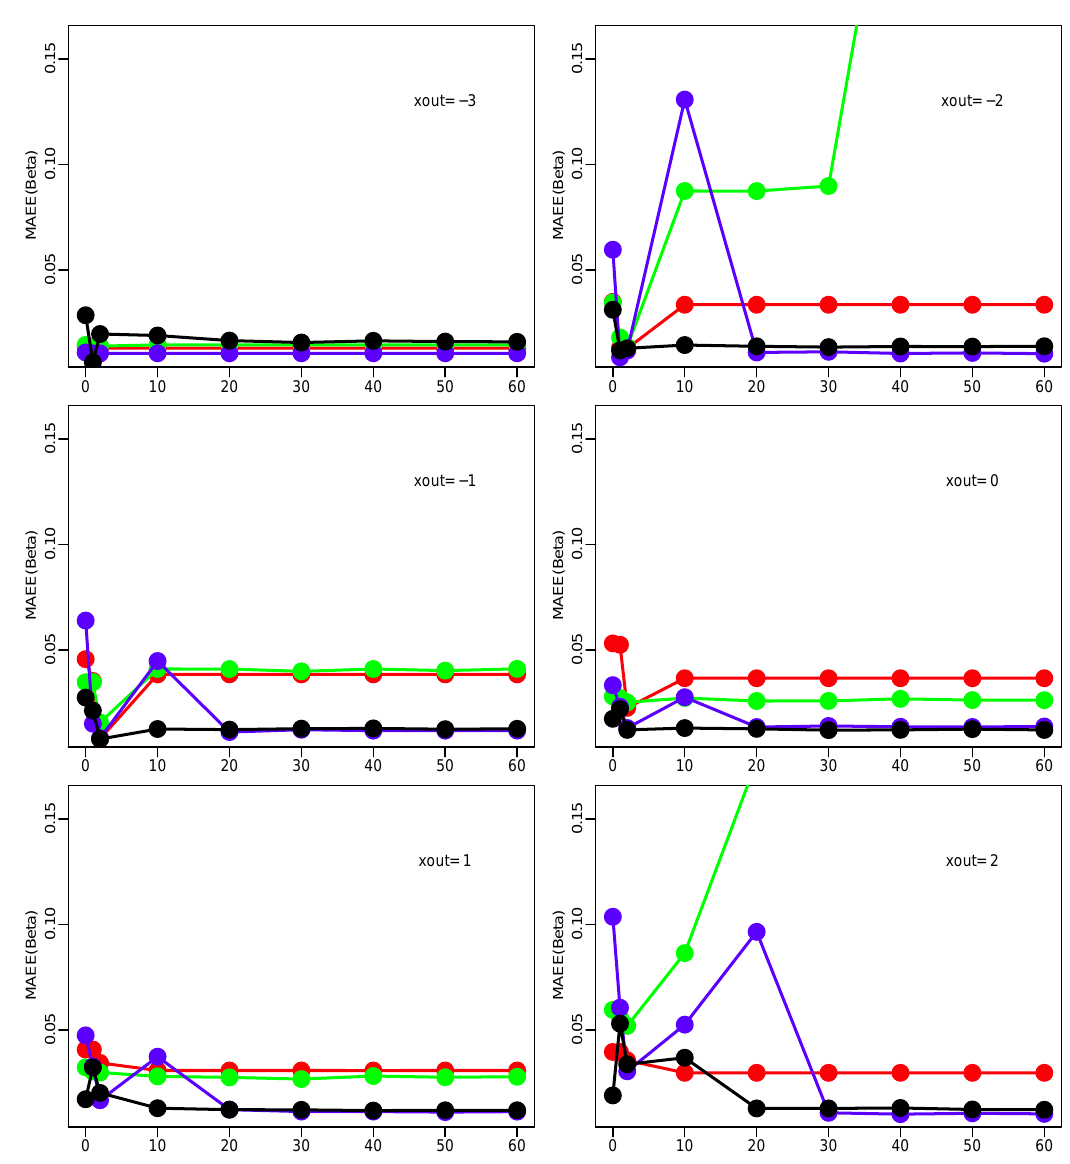
Figure 1. Monte Carlo results for the contaminated simple regression model. Mean square estimation error MSEE( ˆ β ) for varying y out and x out . CUBIF11r, red; RQL01r, green; MT-Ir, blue; MD10r,